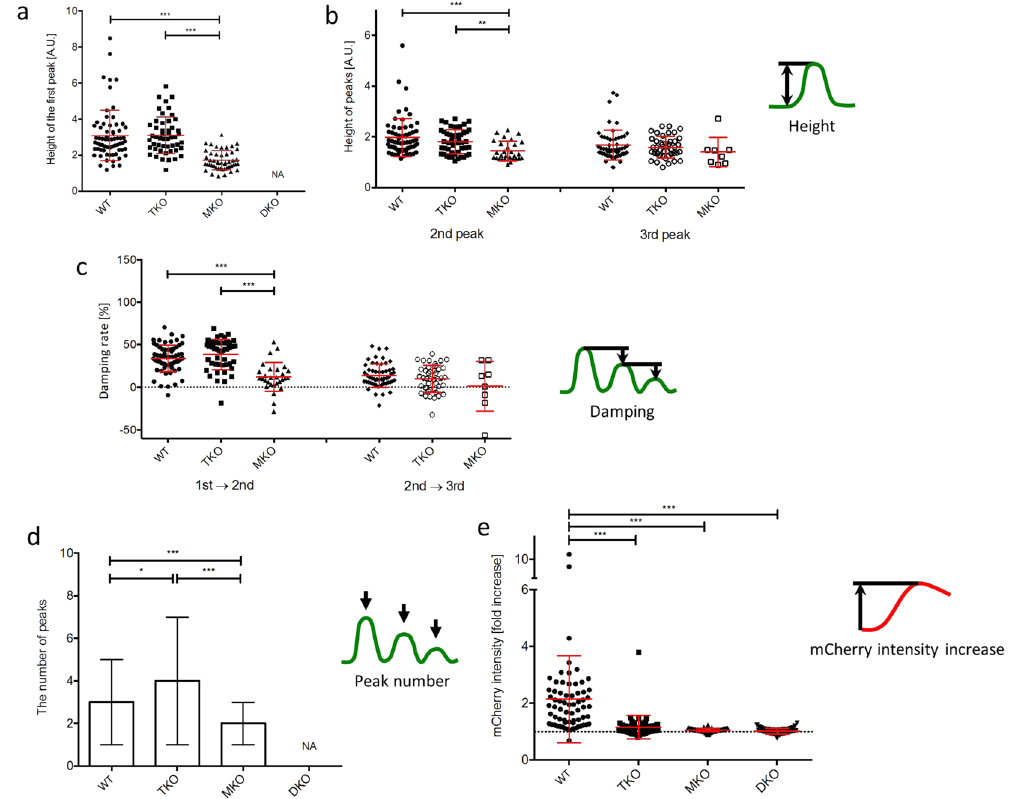
Figure 3. The magnitude of NF- κ B nuclear translocation is not affected by the lack of TRIF-dependent signalling in response to LPS. The number of LPS-induced NF- κ B oscillations does not decrease but TNF α promoter-driven mCherry expression is inhibited in TRIF-deficient macrophages in response to LPS. Each dot shows a single cell from four independent experiments for each cell line. The heights of the first peak ( a ), and the second and third peaks ( b ) of NF- κ B translocation were determined by the value of the highest point in each peak of NF- κ B translocation curve. ( c ) Damping rates indicate the decrease from the first peak to the second peak (1st → 2nd), and from the second peak to the third peak (2nd → 3rd). The bars show mean value ± s.d. *** P < 0.0001, ** P < 0.01, one-way ANOVA with Kruskal-Wallis test. ( d ) The number of peaks in NF- κ B nuclear translocation dynamics. Peaks above noise level that was determined by NF- κ B curve in unstimulated cells were counted. The bars show median with range. ( e ) The fold increase of mCherry fluorescence intensity in response to LPS. Each dot shows a single cell from four independent experiments for each cell line. The bars show mean value ± s.d. The dot line indicates an one-fold (no increase). *** P < 0.0001, * P < 0.05, one-way ANOVA with Kruskal-Wallis